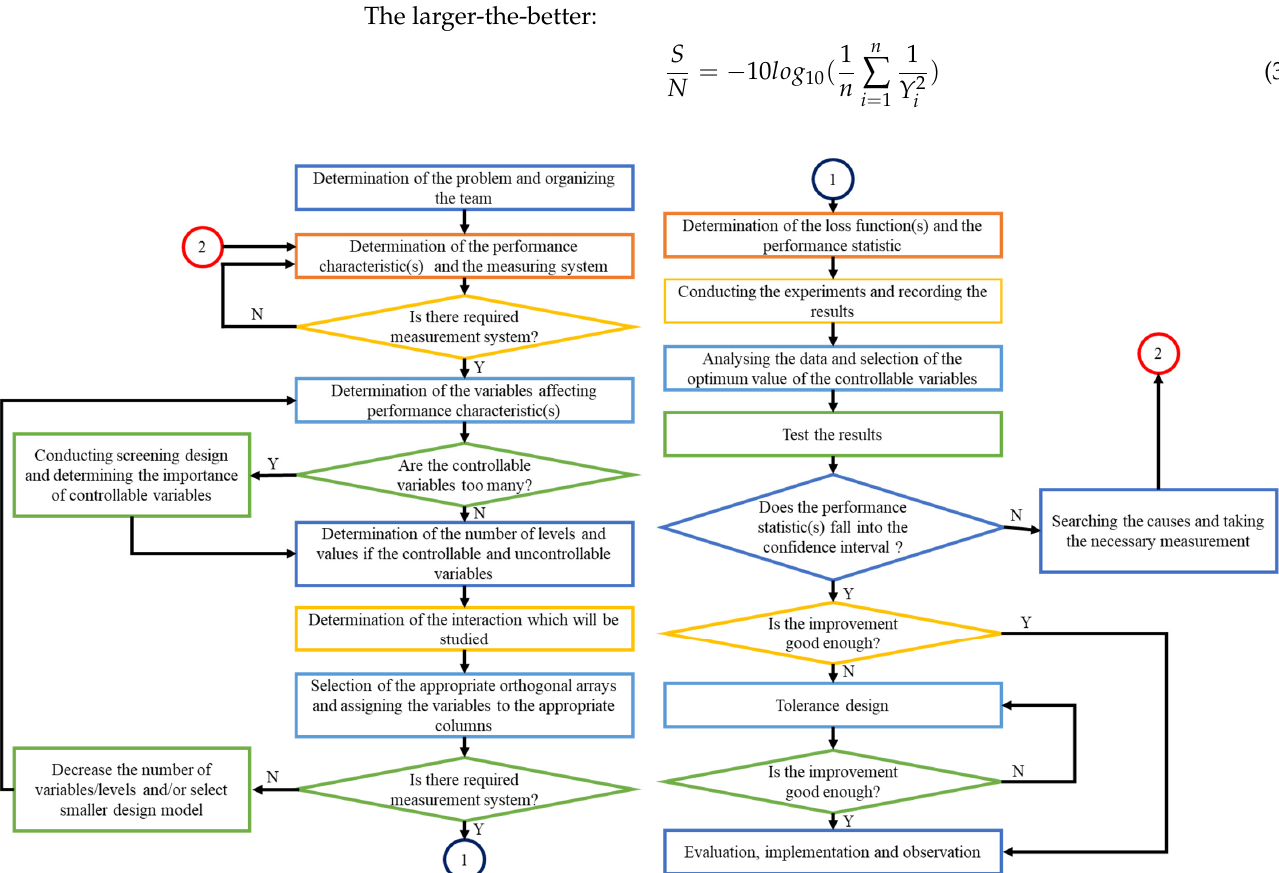
Figure 3. Flowchart of the systematic Taguchi method [31].